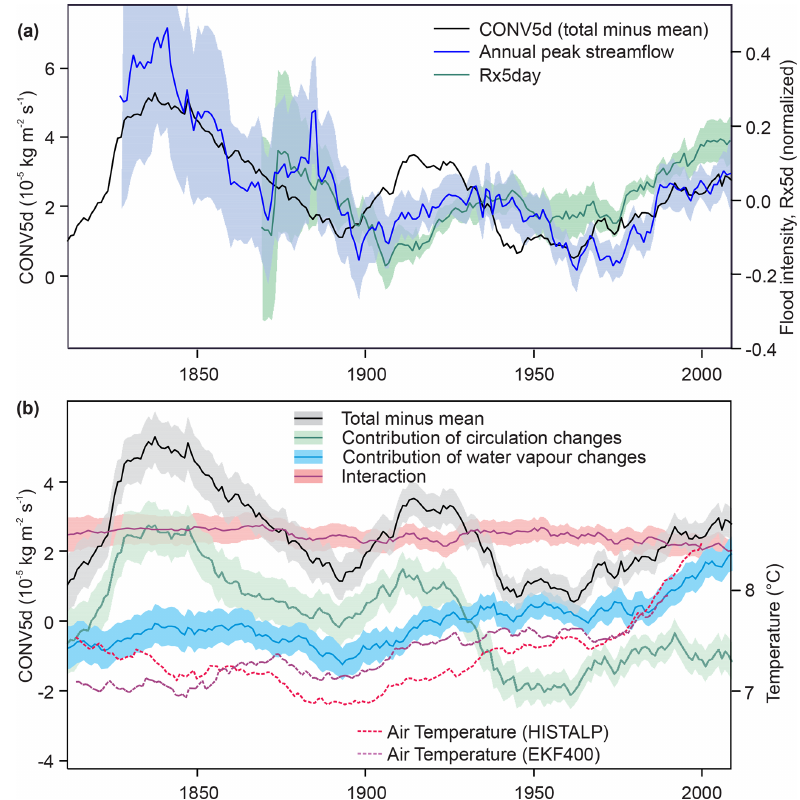
Figure 5. (a) Average of regional averages of annual maxima of peak streamflow, Rx5day, and CONV5d. Shading indicates ± 1 standard error. (b) Contributions to CONV5d from circulation changes, water vapour changes, and their interaction. Shading indicates ± 1 standard deviation of the ensemble. Dashed curves show annual mean temperature from HISTALP and EKF400. All curves are smoothed with a 30-year moving